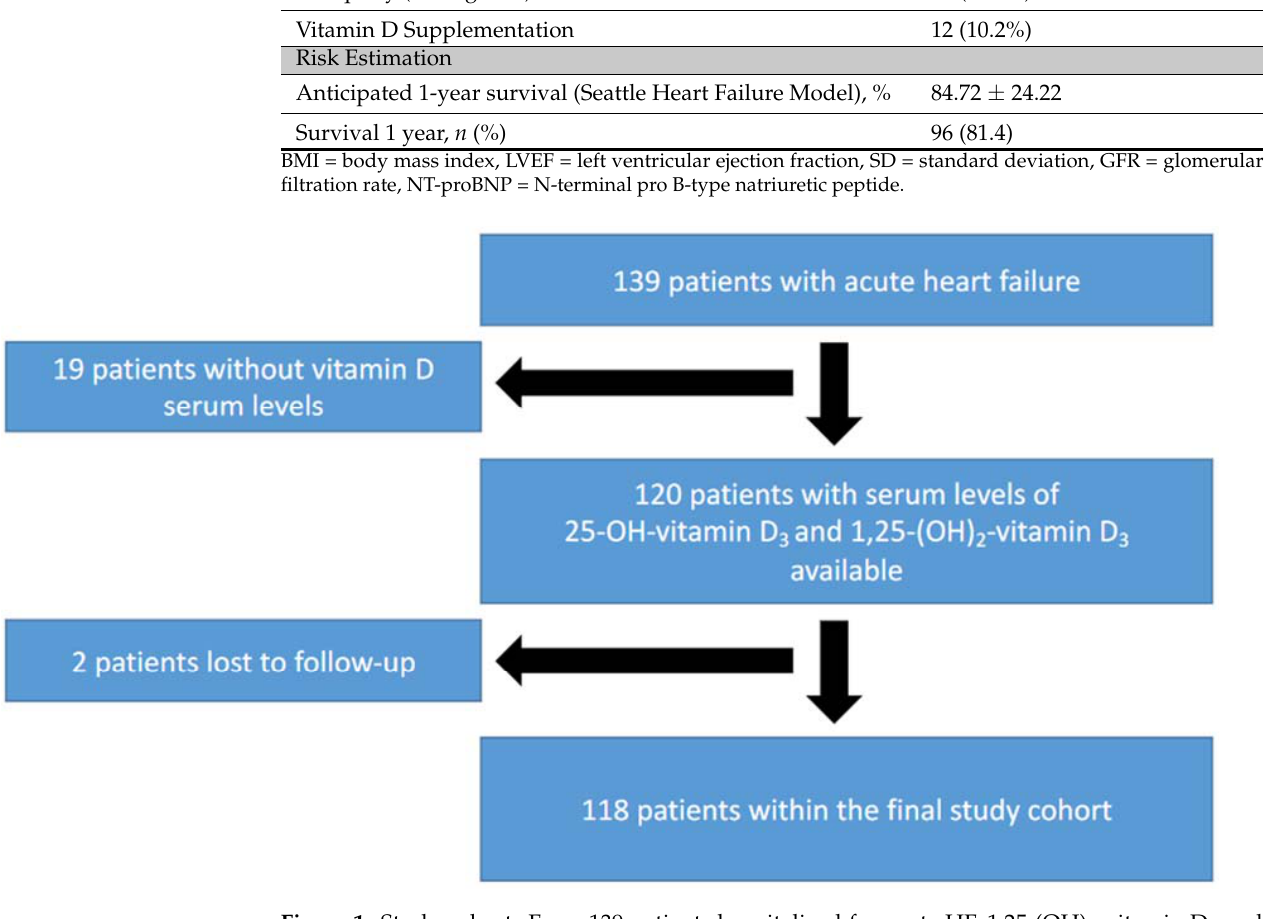
Figure 1. Study cohort. From 139 patients hospitalized for acute HF, 1,25-(OH) 2 -vitamin D 3 and 25-OH-vitamin D 3 levels were available in 120 patients. Two patients were lost to follow-up. The final study cohort comprised 118 patients. Table 1. Baseline characteristics.